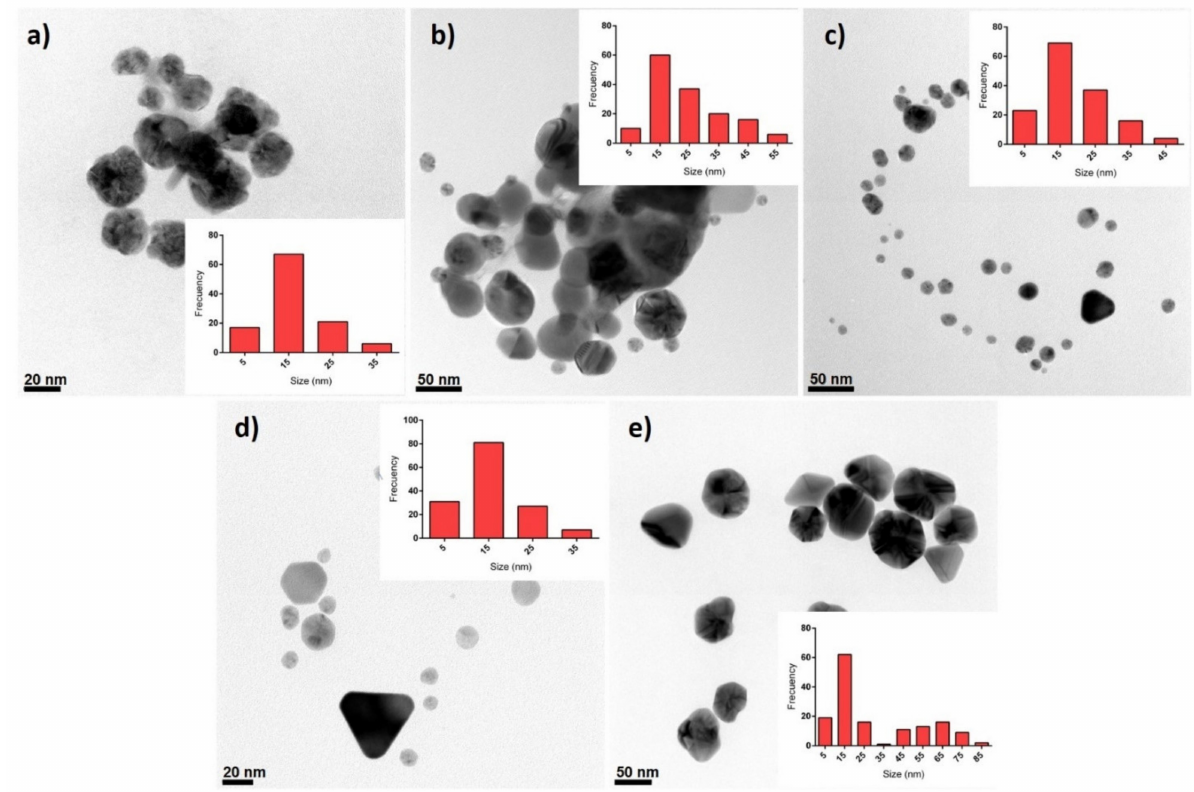
Figure 1. HR-TEM micrographs of the five AgNPs studied in this work ( a ) AgNP1, ( b ) AgNP2, ( c ) AgNP3, ( d ) AgNP4, and ( e ) AgNP5. The inset on each figure corresponds to the size